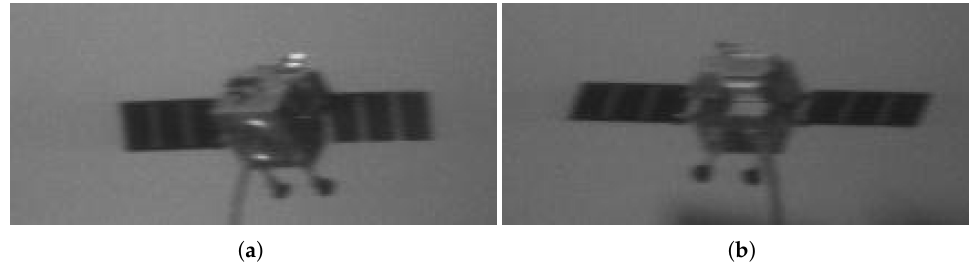
Figure 12. Examples of the measured data: ( a ) example 1; ( b ) example 2. The measured data band range is from 440 nm to 780 nm, and the spectral resolution is 10 nm. The material classes in the measured data are solar cell, gold mylar, antenna, and cooling area. The normalized materials’ spectra of these are shown in Figure 13, where the spectral features of the gold mylar on the vertical incidence surface and the